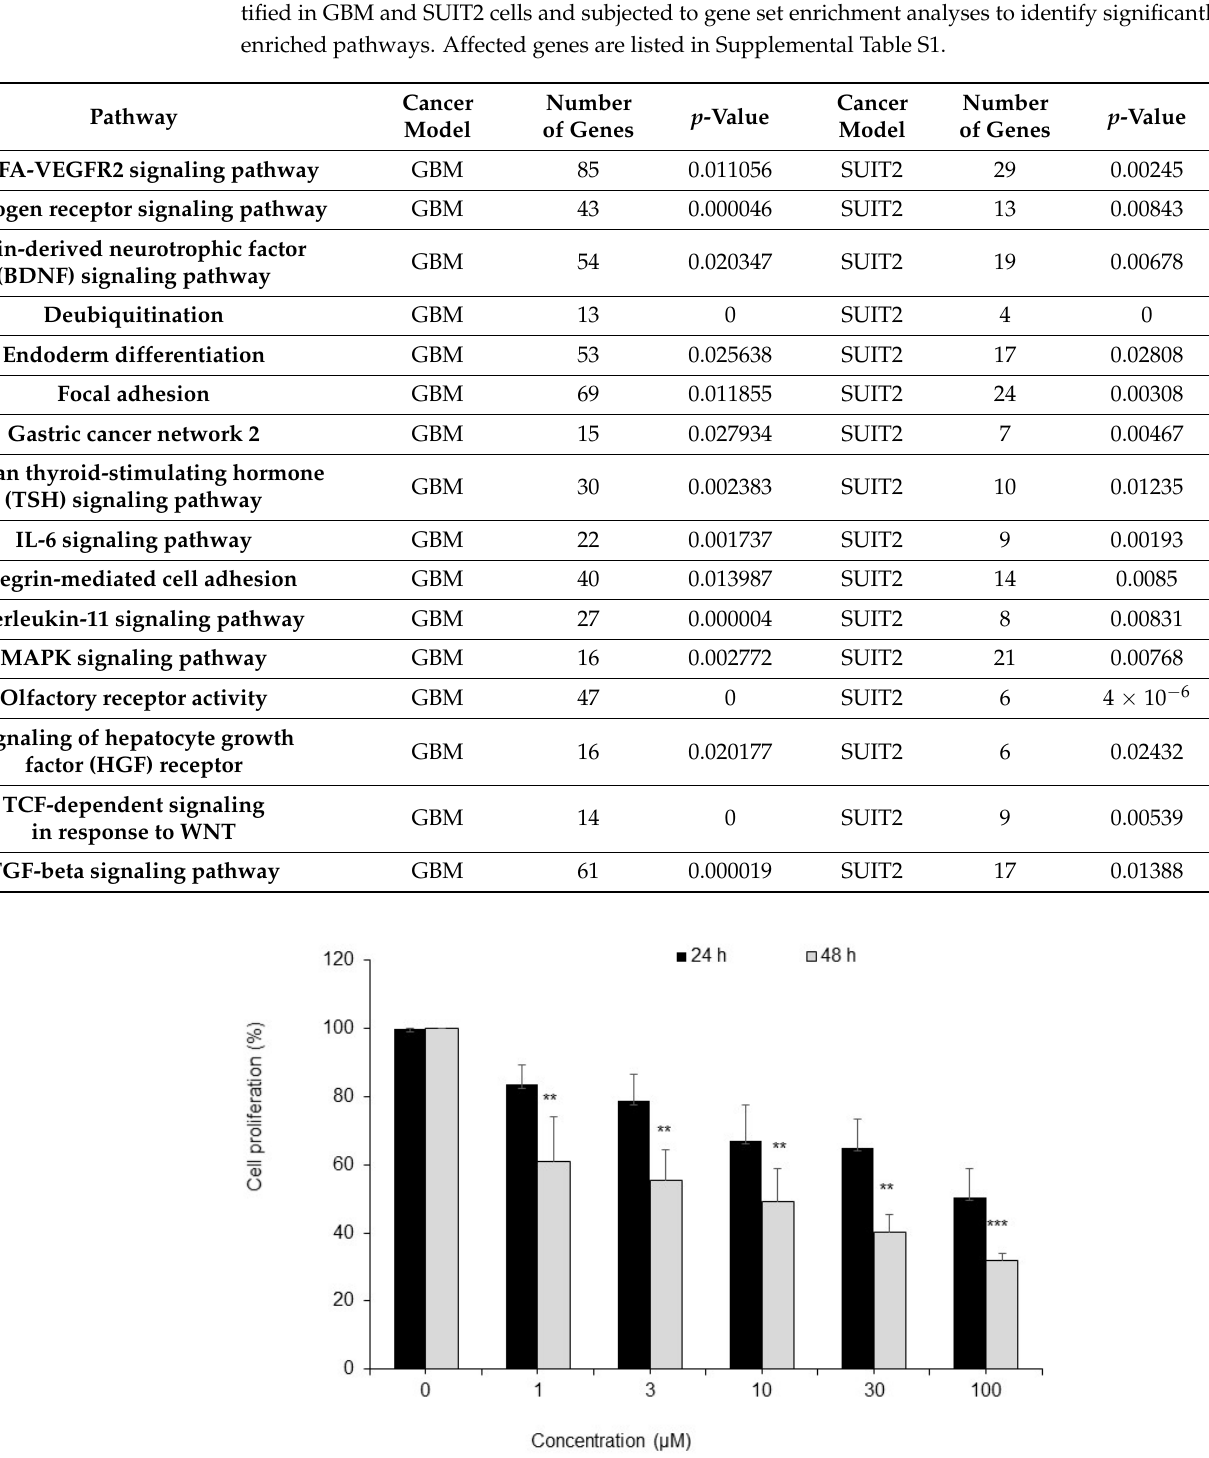
Figure 5. Cell proliferation assay demonstrates dose- and time-dependent inhibitory effects of the P-bi-TAT on human glioblastoma cells. U87-luc cells were incubated with P-bi-TAT at different concentrations (1, 3, 10, 30 and 100 µ M) for 24 h and 48 h and were measured with MTT assay. Values are presented as mean ± SD of three independent experiments. ** p < 0.01, *** p < 0.001, compared to control (PBS).